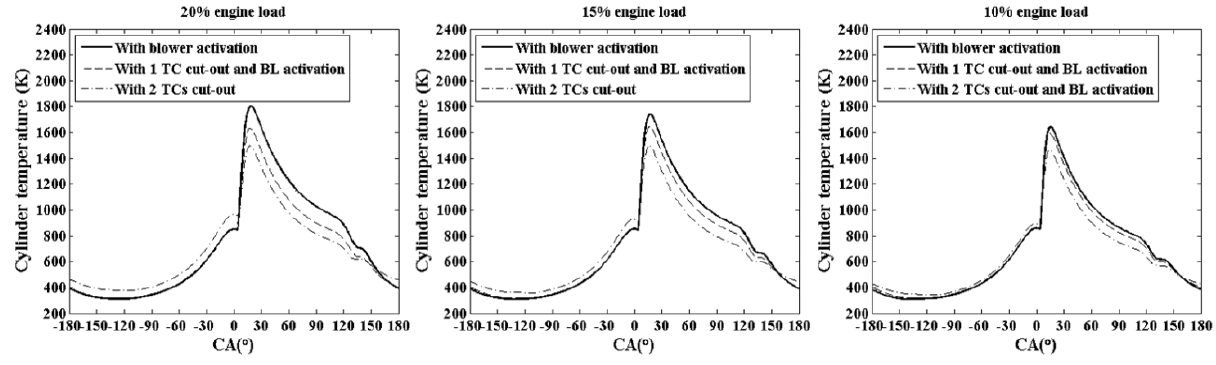
Figure 8. Cylinder temperature at different conditions.